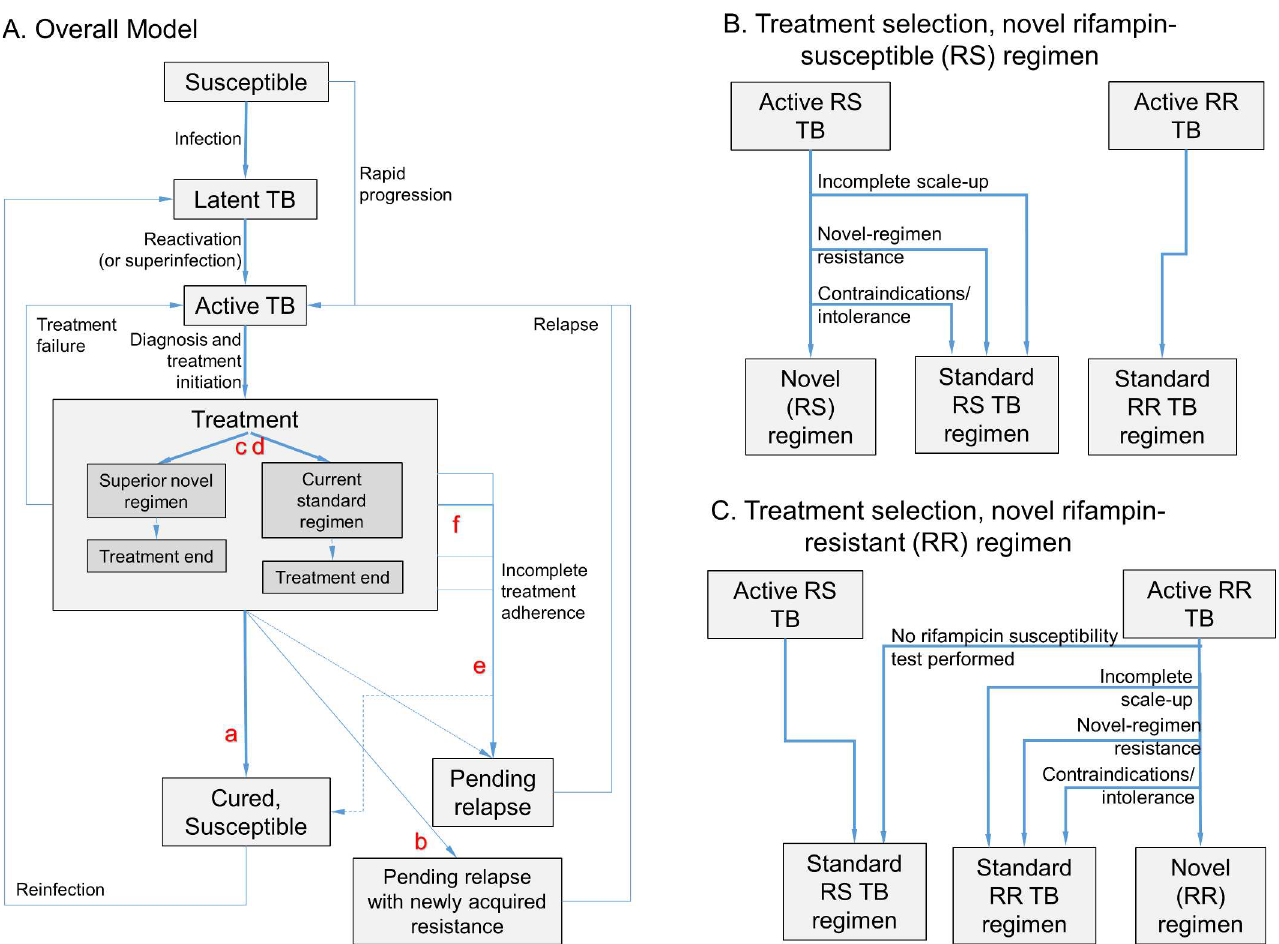
Fig 1. Model structure. The model (panelA) includesinfection, rapid or slow progression to active TB, and initiationof treatment with a standard regimenor novel regimen (the transition from Active TB to Treatment, shown in more detail in panels B and C). (Also includedin model but not shown in Fig 1: parallelstructure for eight different drug resistancephenotypes; parallelstructure for HIV infected/uninfected and treatment na ï ve/ experienced; and death/spontaneousresolution.)Six novel drug regimen characteristics were evaluatedwithin this transmission model; improved novel regimen (a) efficacy increasesthe probabilityof durablecure. A high barrier to resistance (b) prevents acquisitionof resistanceto drugs in the novel regimen. Less preexisting resistanceto componentsof the novel regimen(c) and fewer medicationcontraindicationsor treatment-limiting toxicities associated with the novel regimen (d) increasethe number of patients for whom the novel regimen is prescribed.Shorter regimen duration (e) and greater ease of adherence (f) both increase treatment completion, and shorteneddurationalso reduces the probabilityof cure after loss to follow-upat any given time point.